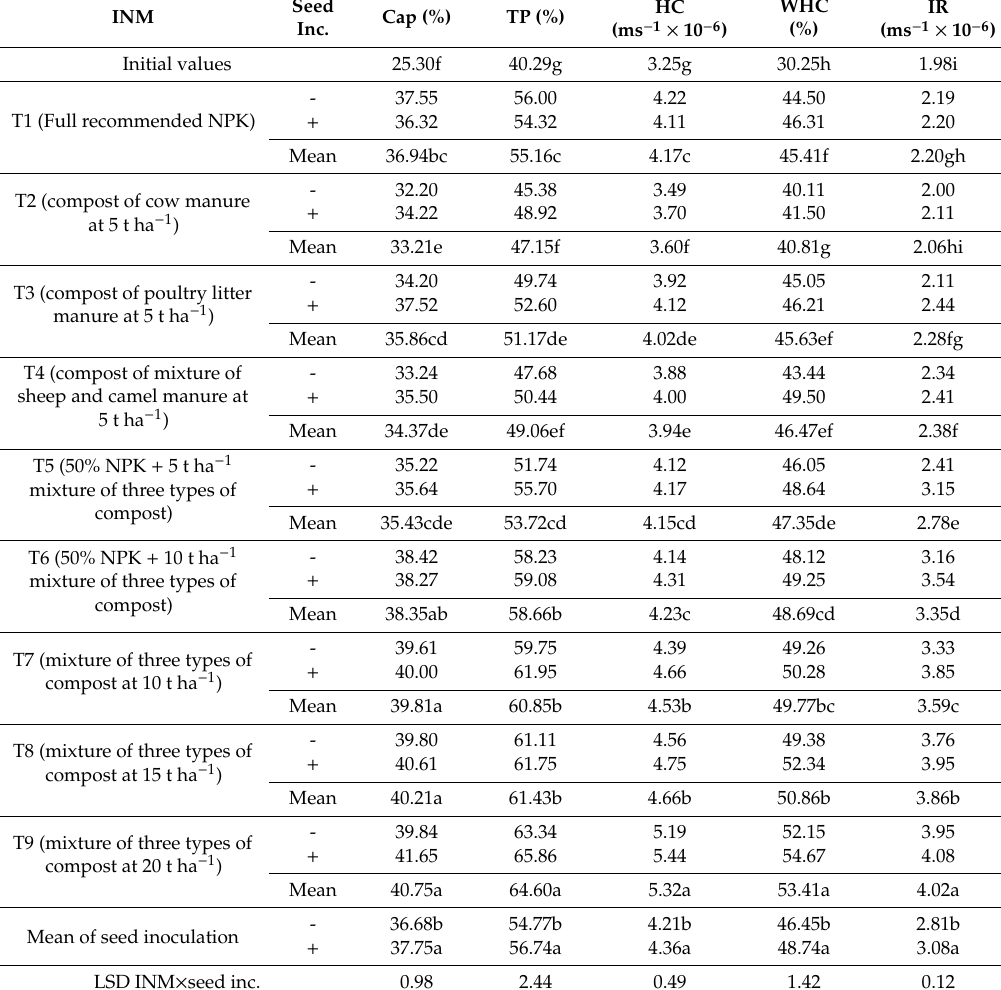
Table 3. E ff ects of di ff erent integrated nutrient management (INM) with ( + ) and without ( − ) seed inoculation (seed Inc.) on soil physical properties (mean, n = 4) after 2 years of field-scale experiments: capillary (cap), total porosity (TP), hydraulic conductivity (HC), water holding capacity (WHC), and infiltration rate